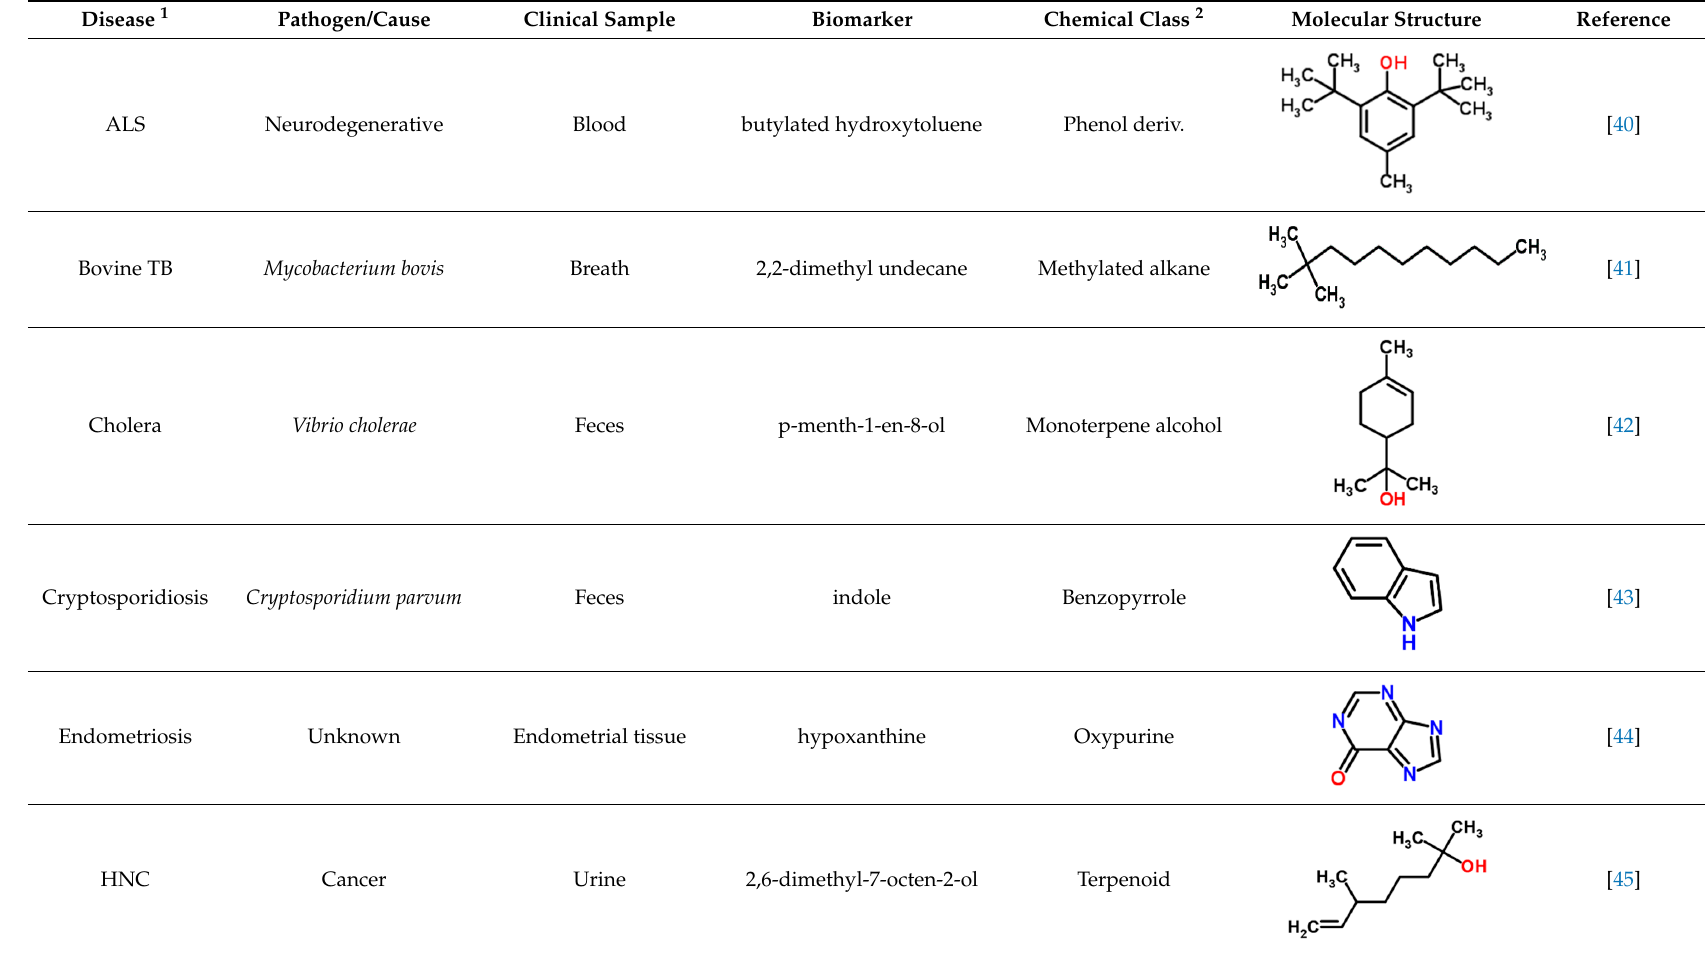
Table 2. Chemical classes and molecular structures of diverse biomarker metabolites with potential for facilitating the noninvasive early diagnosis of diseases.